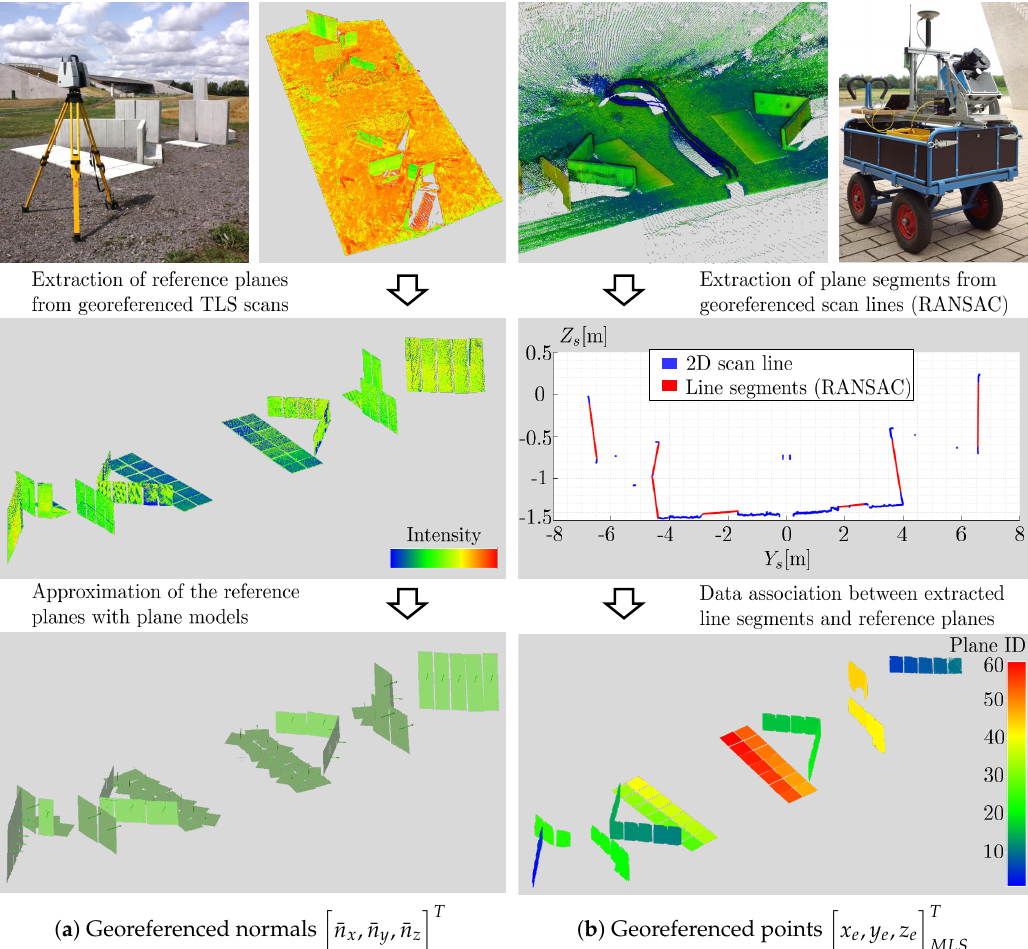
Figure 3. ( a ) Generating reference normals for the plane setup using TLS (Terrestrial Laser Scanning), ( b ) Generating a point cloud of the plane setup using the mobile laser scanning system. The scan points of the mobile laser scanning system are automatically extracted from the scan lines using RANSAC (Random Sample Consensus) and assigned to the correct reference